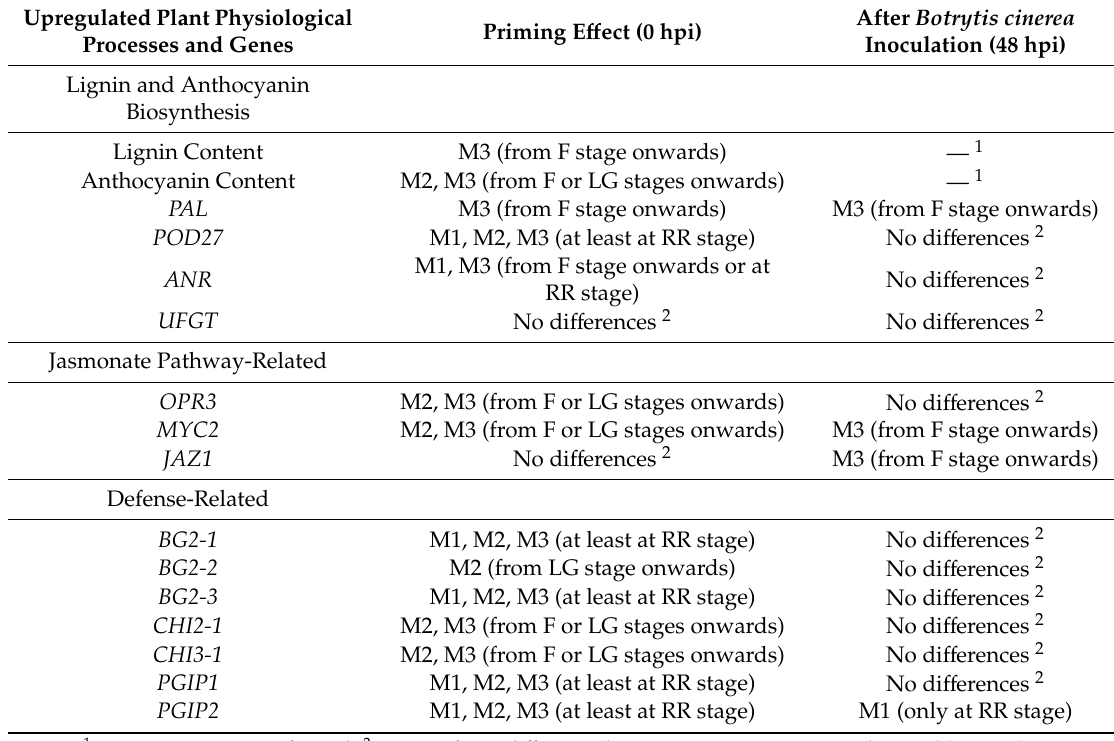
Figure 2. Lignin and anthocyanin contents of di ff erent methyl jasmonate (MeJA)-treated strawberry ( Fragaria × ananassa ‘Camarosa’) fruit at postharvest (0 hpi). Changes in ( a ) lignin and ( b ) anthocyanin contents in fruit subjected to di ff erent methyl jasmonate treatments during fruit development (C, M1, M2, and M3) and analyzed postharvest. Data were analyzed by ANOVA test, and di ff erences between means ± standard error (SE) ( n = 3) were determined using the LSD test. Asterisks indicate significant di ff erences between treatments and control (* p < 0.05; *** p < 0.001). For experimental details, see the Materials and Methods section. Table 2. Upregulation of specific plant physiological processes and gene expression in di ff erent methyl jasmonate (MeJA) treatments (M1, M2, and M3) and corresponding developmental stages (F, LG, RR) of strawberry ( Fragaria × ananassa ‘Camarosa’) regarding control (C) treatment both in 0 and 48 hpi. F: flowering; LG: large green fruit; RR: 100% red ripe fruit. For experimental details, see the Materials and Methods